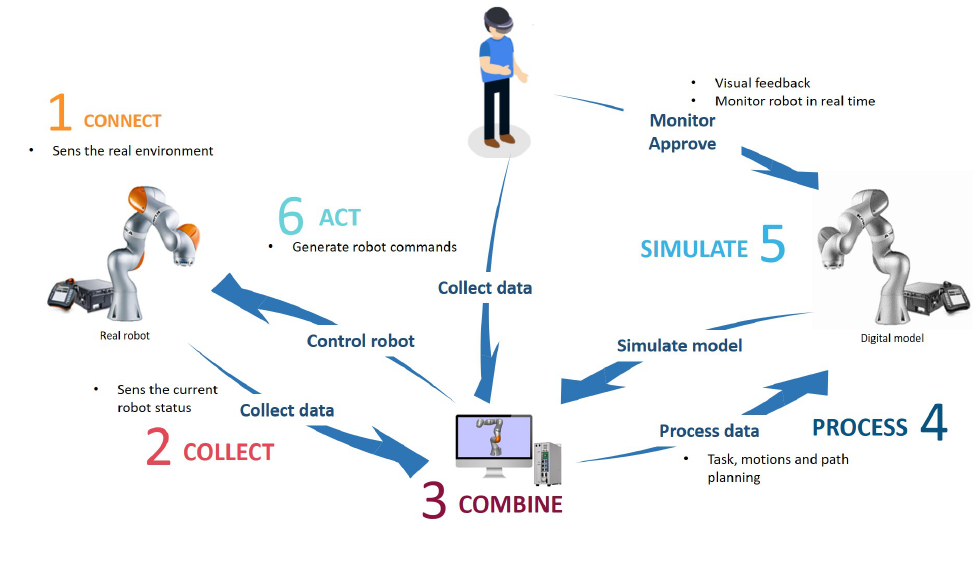
Figure 2. The HRI application of the DT framework. Table 2. Information on the physical equipment, integrated sensors and their